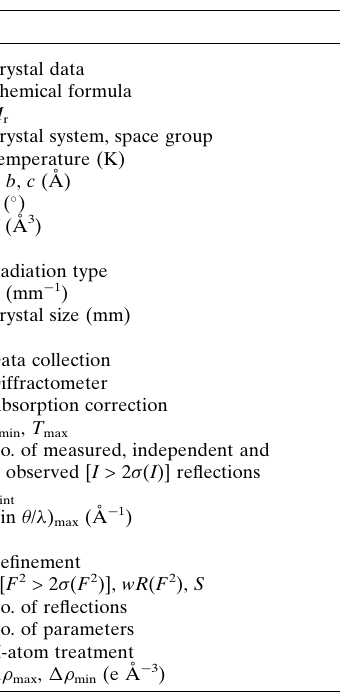
Table 3 Experimental details.